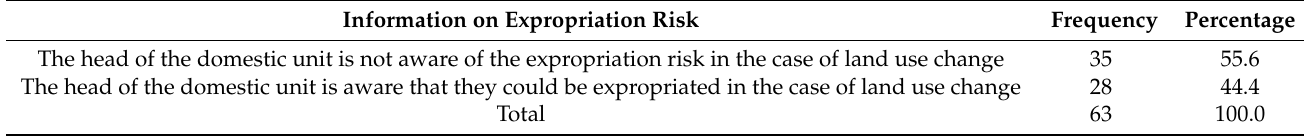
Table 1. Proportion of domestic units informed of the expropriation risk in Kimonyi Sector.